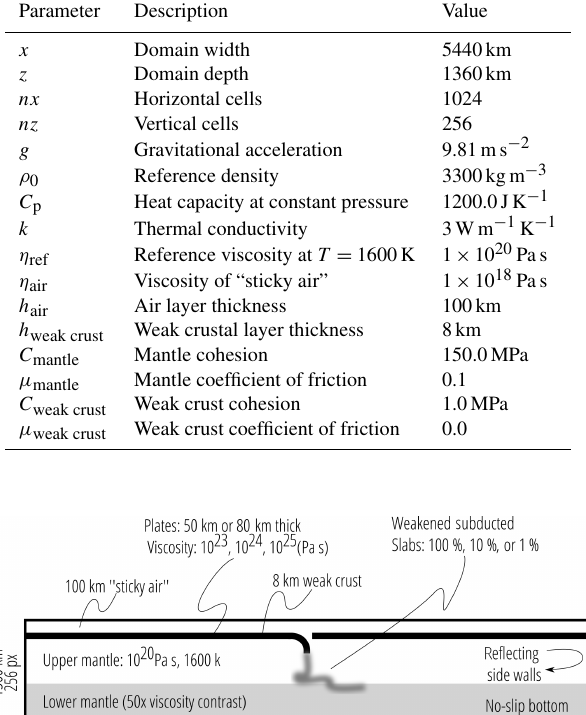
Table 1. Parameters common to all models.